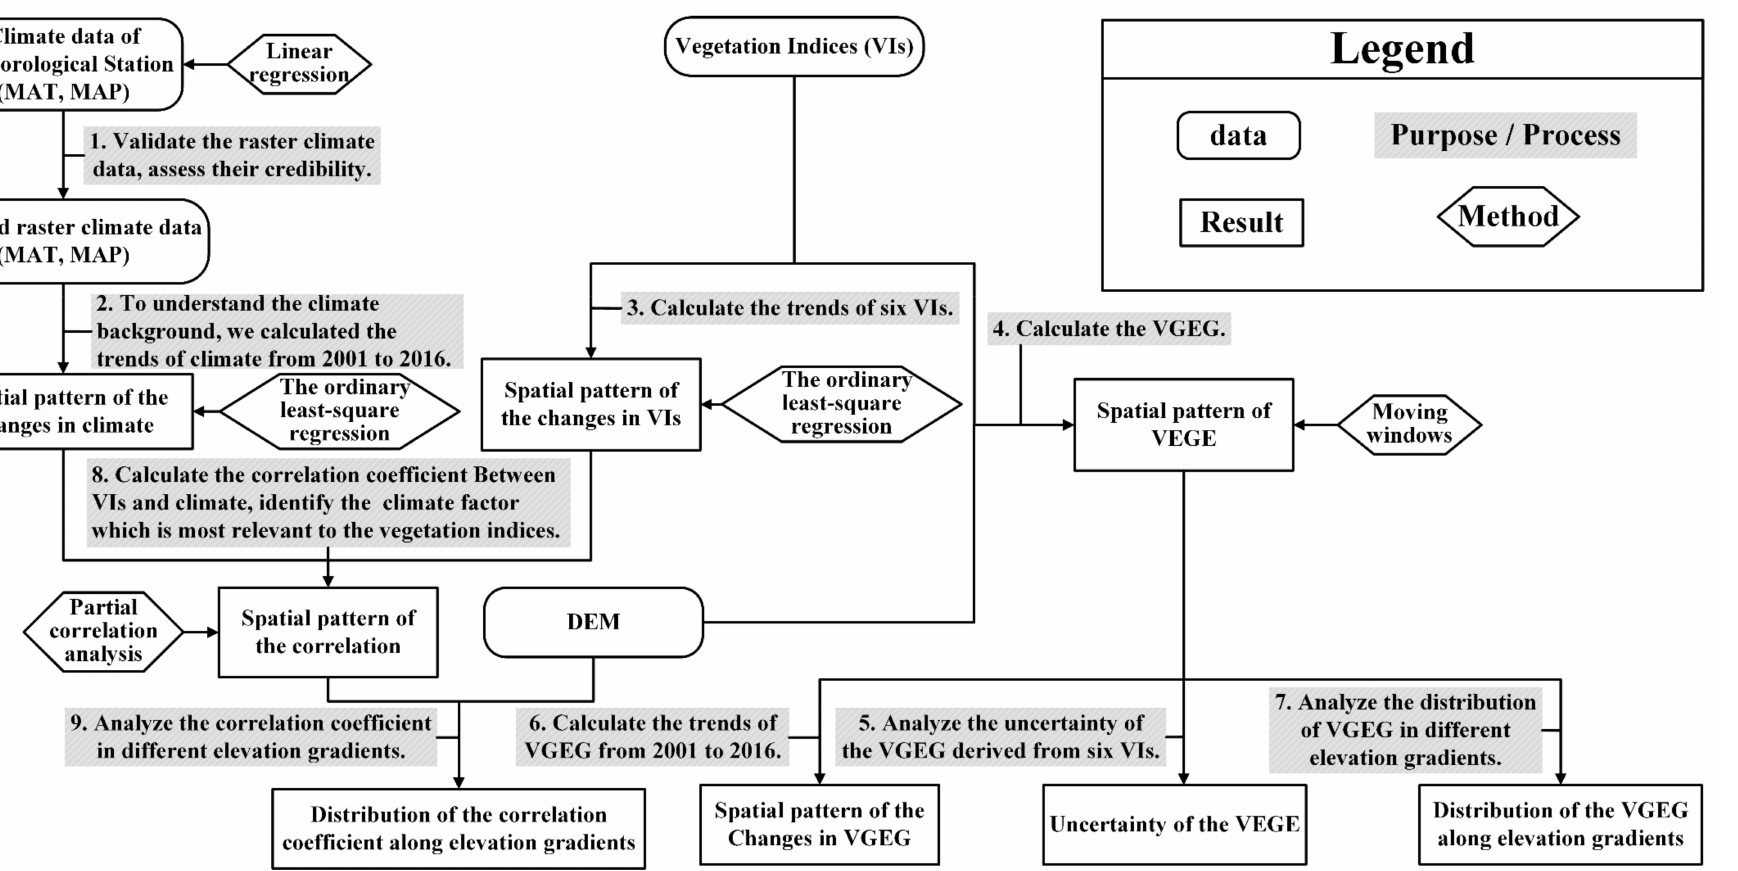
Figure 3. Flowchart of the data processing and analysis in this study. MAT: Mean Annual Temperature. MAP: Mean Annual Precipitation. DEM: Digital Elevation Model. VGEG: Vegetation Greenness along the Elevation